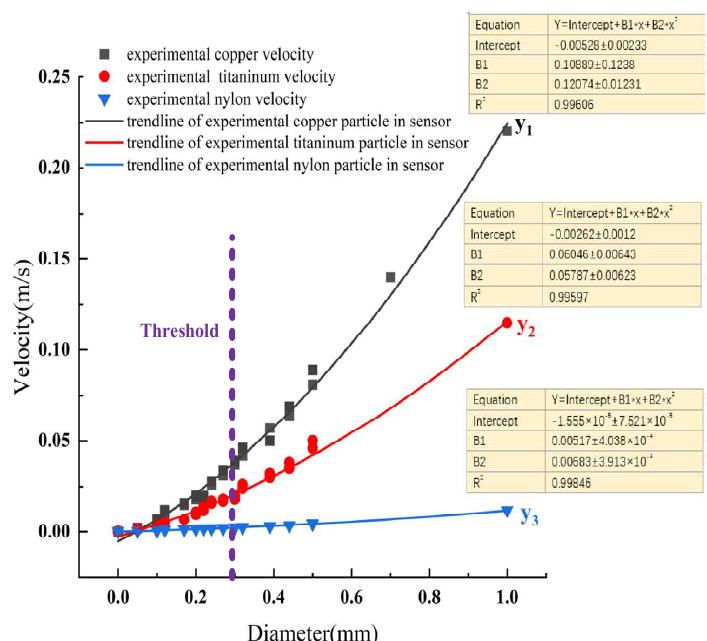
Figure 17. Velocities of particles with different properties, and their fitting curves in the experiment.